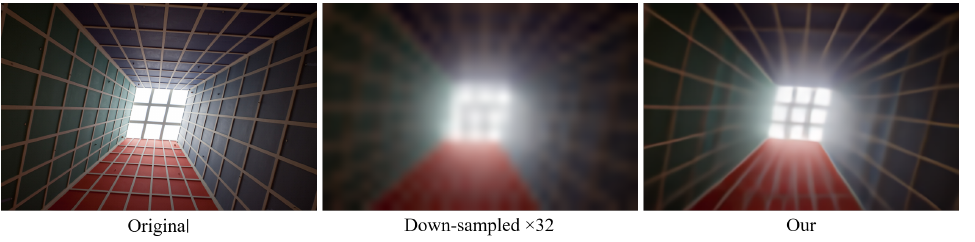
Figure 2. Comparison of original version and down-sampled version of full image and the super- resolution results with our